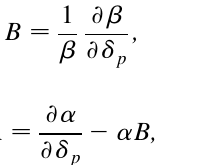
ffiffiffiffiffiffi p (cid:1) -beating values at (cid:1) (cid:1) ¼ 0 : 6 m for the virgin machine and after local and global x